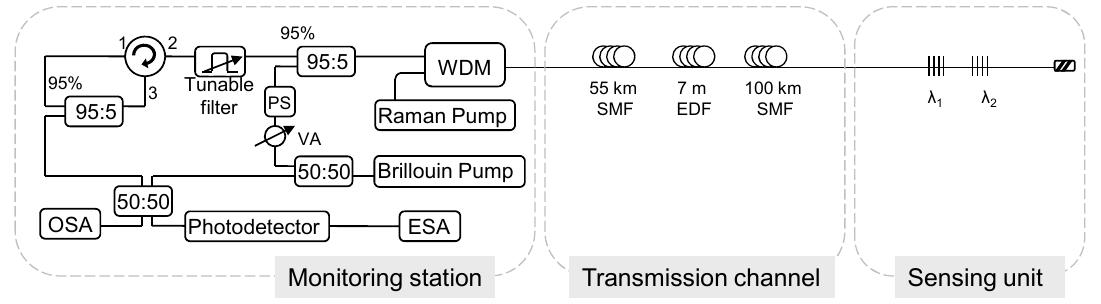
Figure 9. Experimental set-up sued for remote interrogation for two FBGs. Adapted from